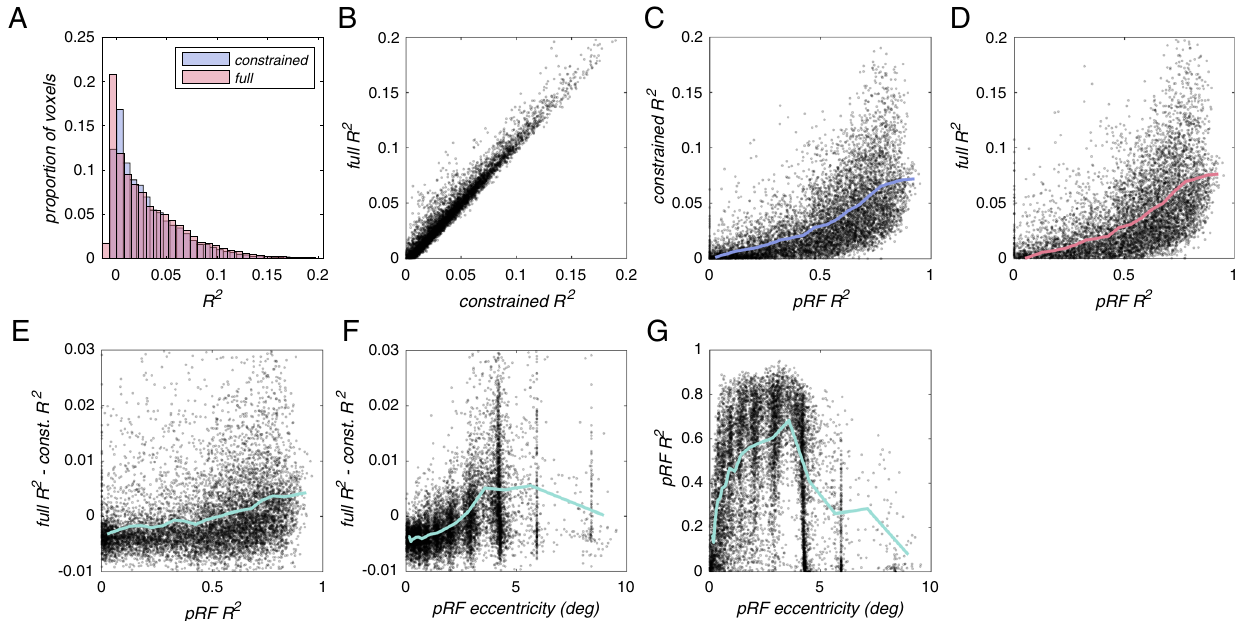
Fig.2|Bothconstrainedandfullmodels fi tvoxelresponses.A Distributionof R 2 values for full (pink) and constrained (blue) models. Distributions for both models weresimilar,withtheconstrainedmodel R 2 medianslightlybutsigni fi cantlyhigher ( p =7.4×10 − 11 ,two-sidedWilcoxonrank-sumtest). B R 2 valuesforthefullmodelasa function of R 2 values for the constrained model. C R 2 values for constrained model